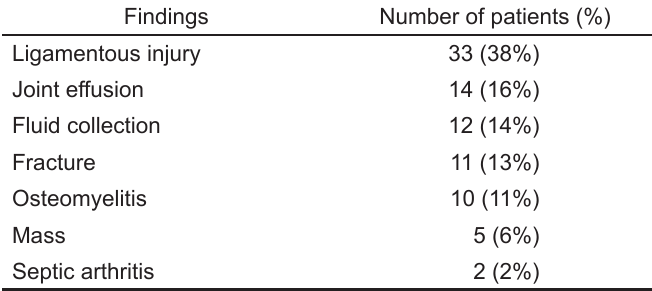
Table 2. Prevalence of findings on musculoskeletal extremity MRI exams.